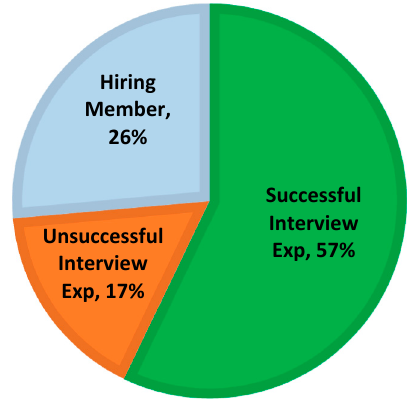
Figure 2. Distribution of Personal Experiences.